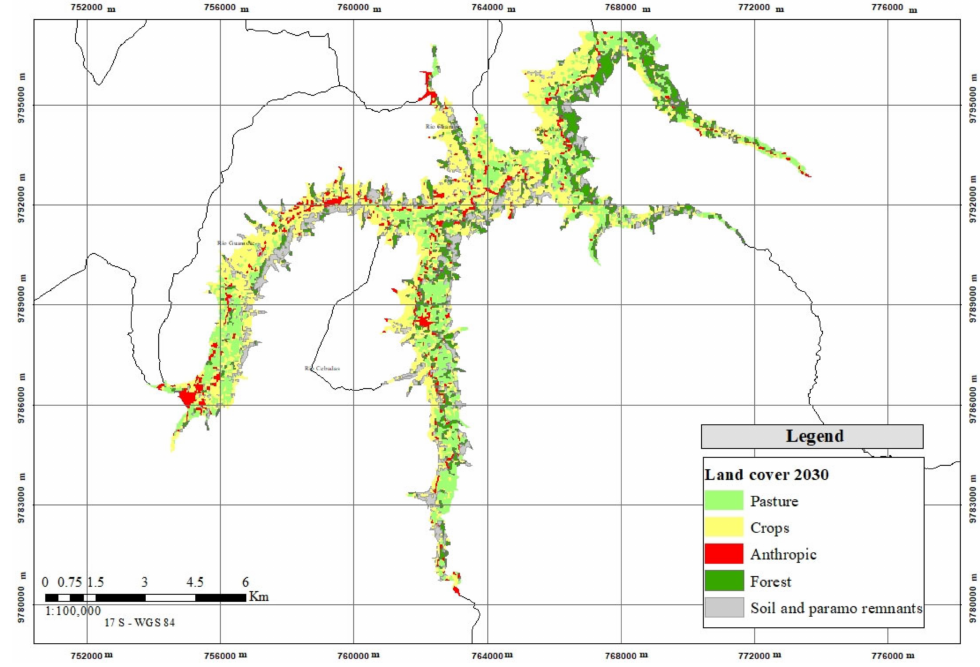
Figure 8. Map of the land cover projection for the year 2030.